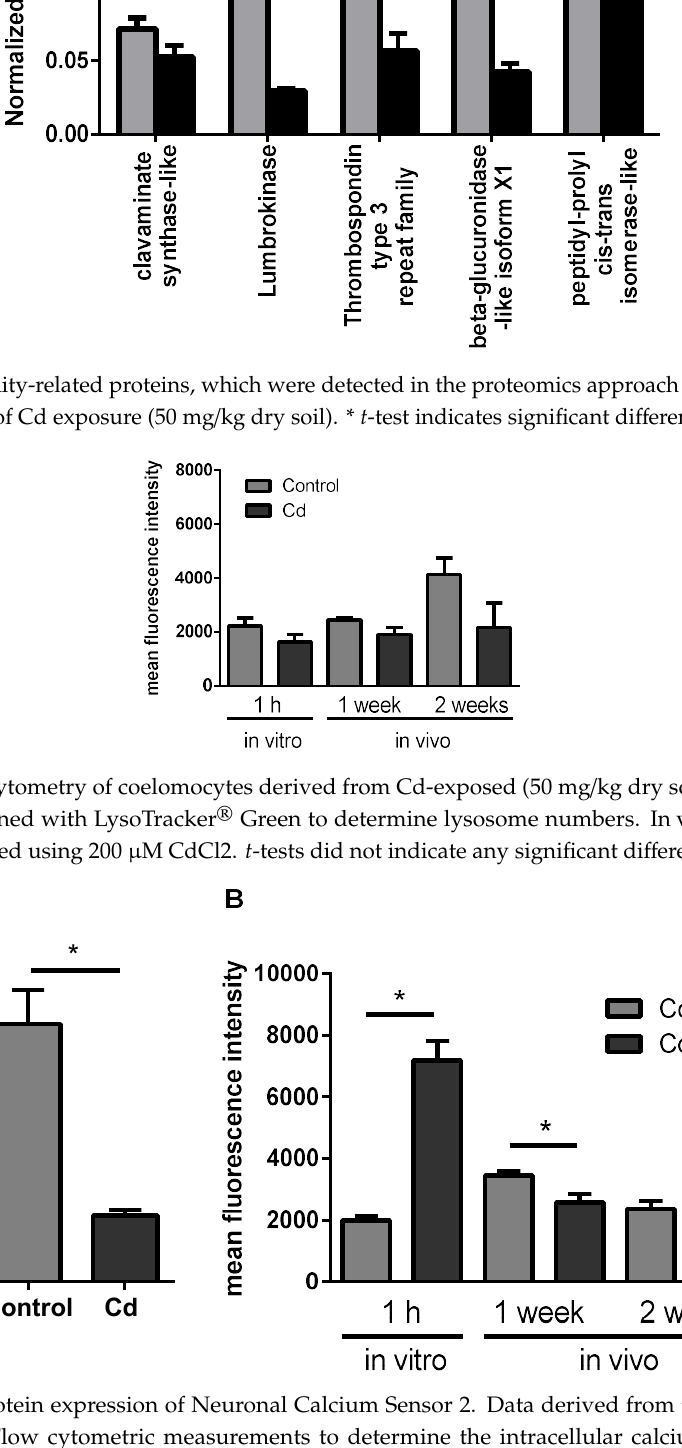
Figure 3. ( A ) Protein expression of Neuronal Calcium Sensor 2. Data derived from the proteomics approach. ( B ) Flow cytometric measurements to determine the intracellular calcium level using